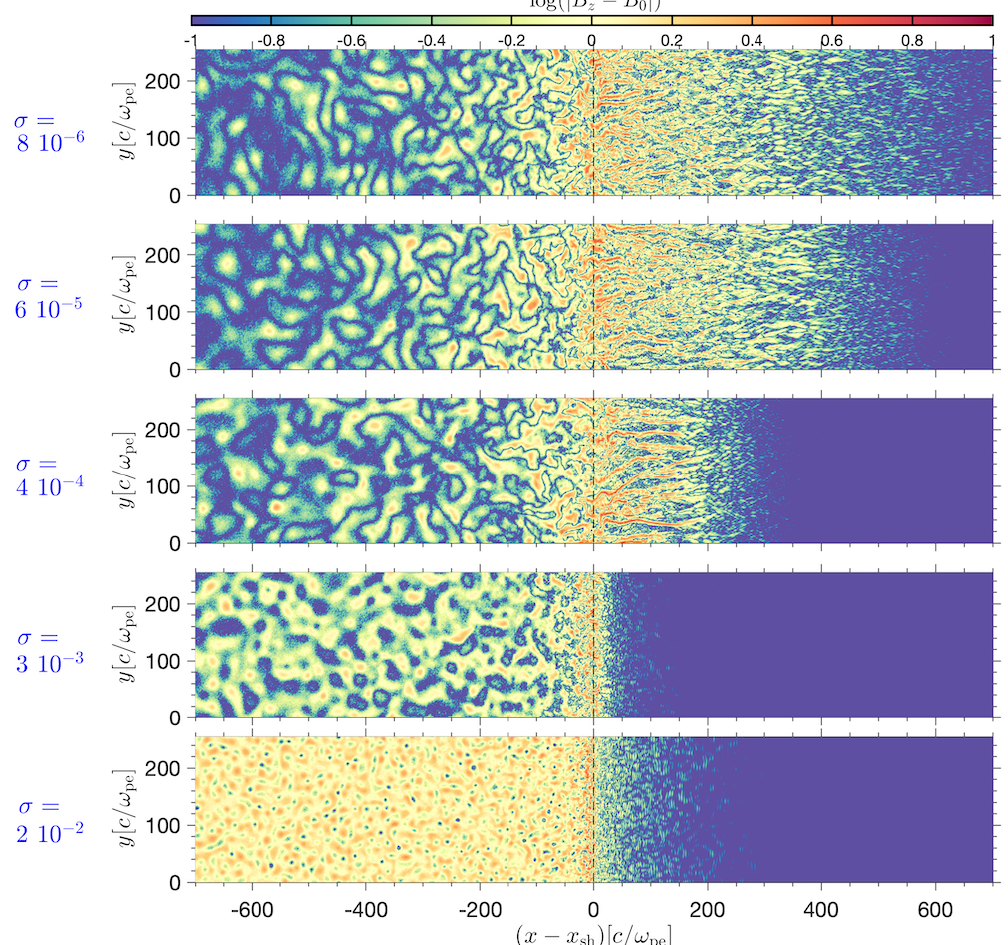
Figure 7. Evolution of the shock layer structure with increasing magnetization of the ambient medium, from 2D3V PIC simulations of a pair shock with Lorentz factor γ sh = 17. Each panel displays the magnetic field enhancement in the simulation plane, ln [ e | B z − B 0 | / ( mc ω pe )] (or, ] ). Five representative magnetizations are presented, from top to equivalently ln [ γ u | d (cid:101) 1/2 B